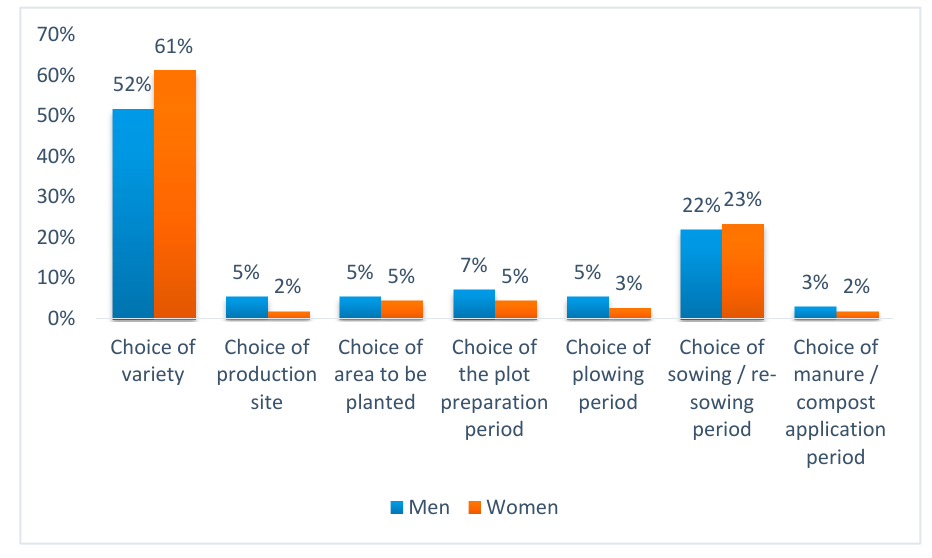
Table 9. Impact of the use of SF on the main crops.